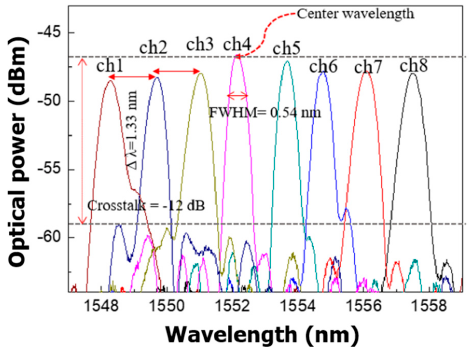
Figure 8. The experimental optical spectra of the silicon transmitter.